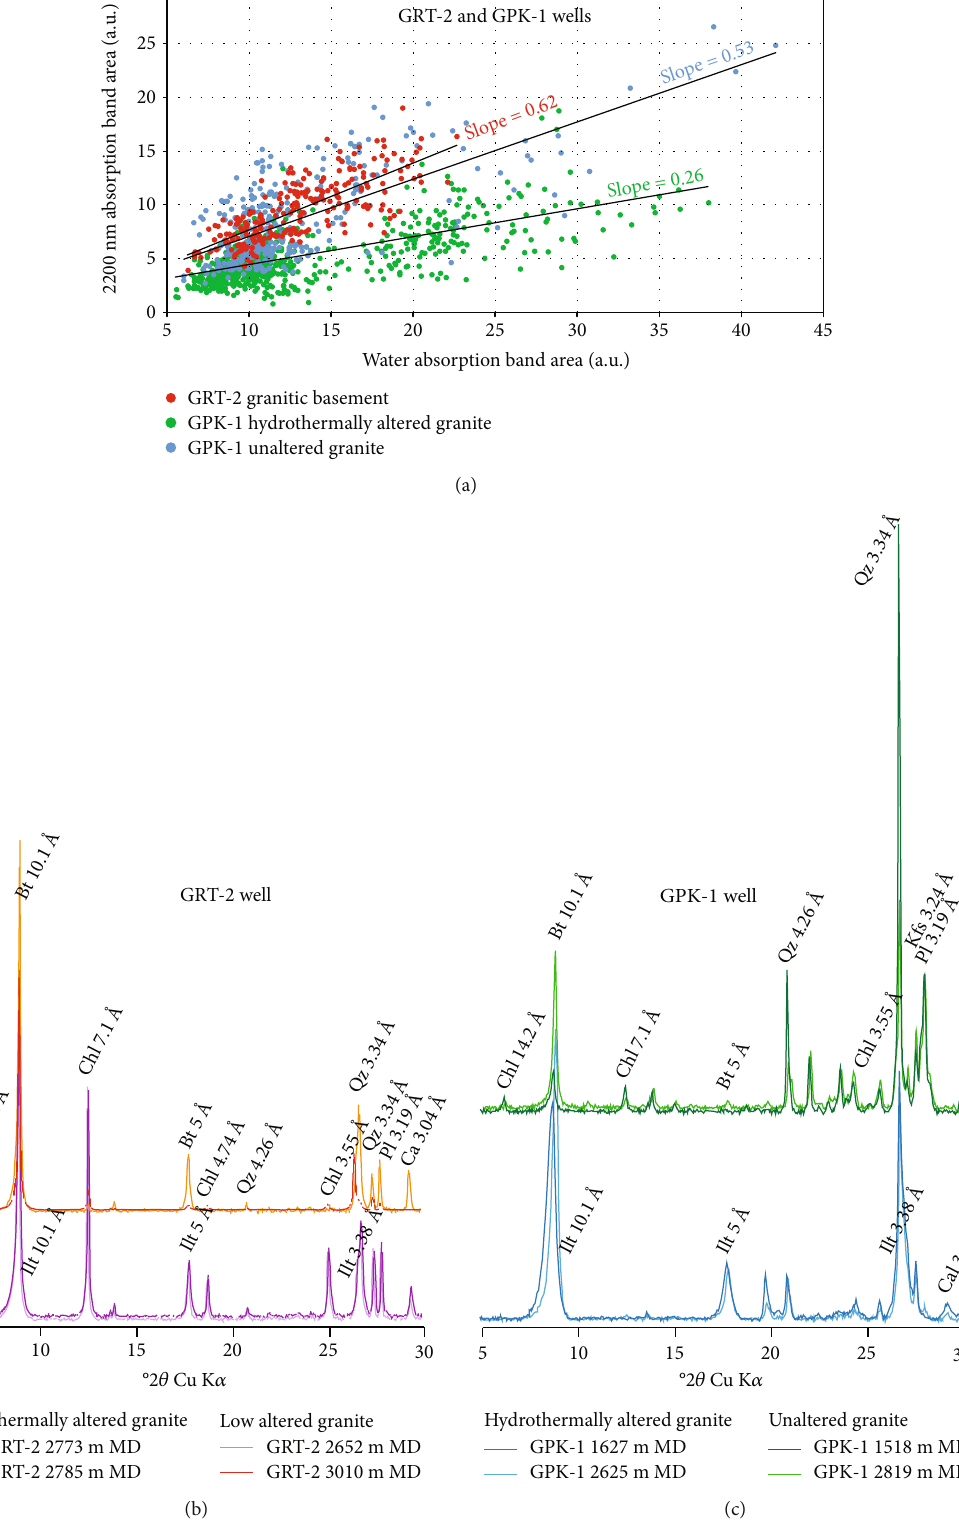
Figure 9: Correlation of the SWIR water and 2200nm absorption band area for (a) the GRT-2 and GPK-1 wells, (b) XRD results for the slightly altered granite and the hydrothermally altered granite in the GRT-2 well, and (c) XRD results for the unaltered granite and the hydrothermally altered granite in the GPK-1